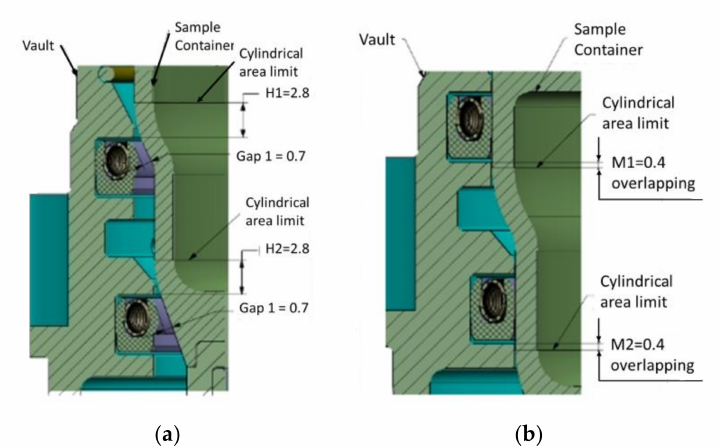
Figure 11. Sample Container nominal positions during the Vault closing operations: ( a ) SC in the start position of the closing operation, ( b ) SC at the end of the closing operation (Vault closed and sealed).